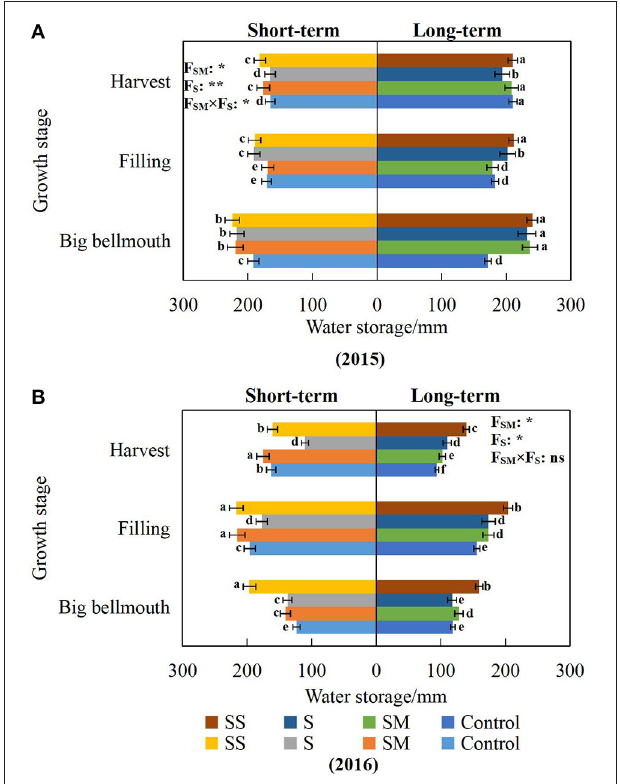
FIGURE 3 | Water storage in different growth stages of wheat under the Control, SM, S, and SS treatments in different years. Error bars represent standard deviation ( n = 3). Columns labeled with different letters represent significant differences at P < 0.05 among treatments of two experiments at same growth stage. (A) 2014962015 and (B) 2015962016. Control, conventional tillage; SM, straw mulching; S, subsoiling; SS, subsoiling + straw mulching. F SM , F S and F SM × F S mean F-values of straw mulching, subsoiling and their interactions in variance analysis respectively. “* and **” indicate difference at the 0.05 and 0.01 probability levels, respectively.